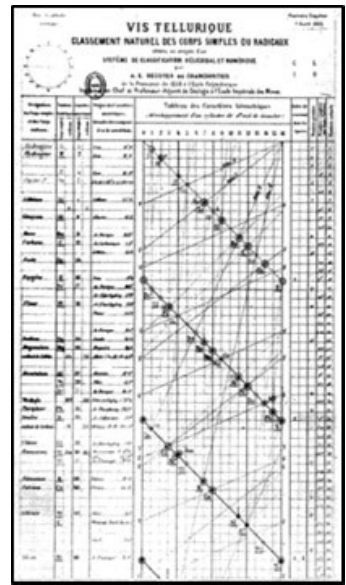
Figure 3. Chancourtois’ listing of the elements [Reproduced by kind permission of the Master and Fellows of St Catherine’s Col- lege,